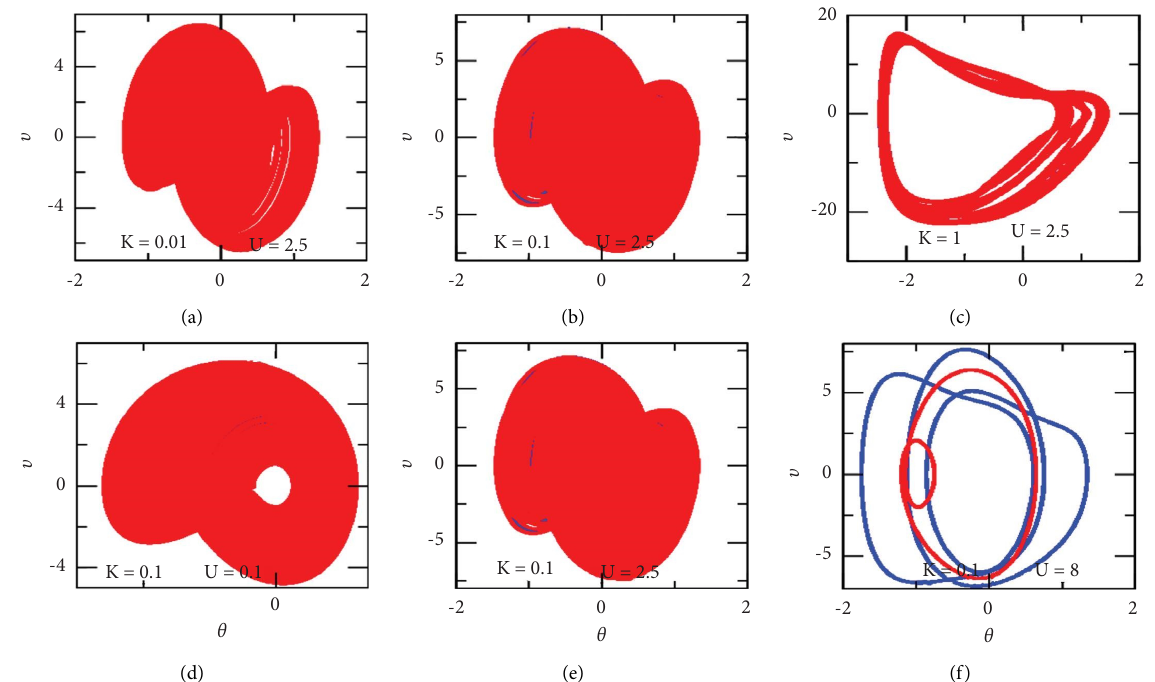
Figure 15: Effect of the parameters K and U on the coexistence of attractors for ϵ � 1 ; F � 45 . 6 ; α � 10 ; β � 1 ; Ω � 2 ; C 0 . 05 ; M � 0 . 1 ; g � 10. Blue phase portrait corresponds to the initial conditions ( 1 ; − 1 ) , while the red phase portrait corresponds to the initial conditions ( 1 ; 1 . 5 ) .